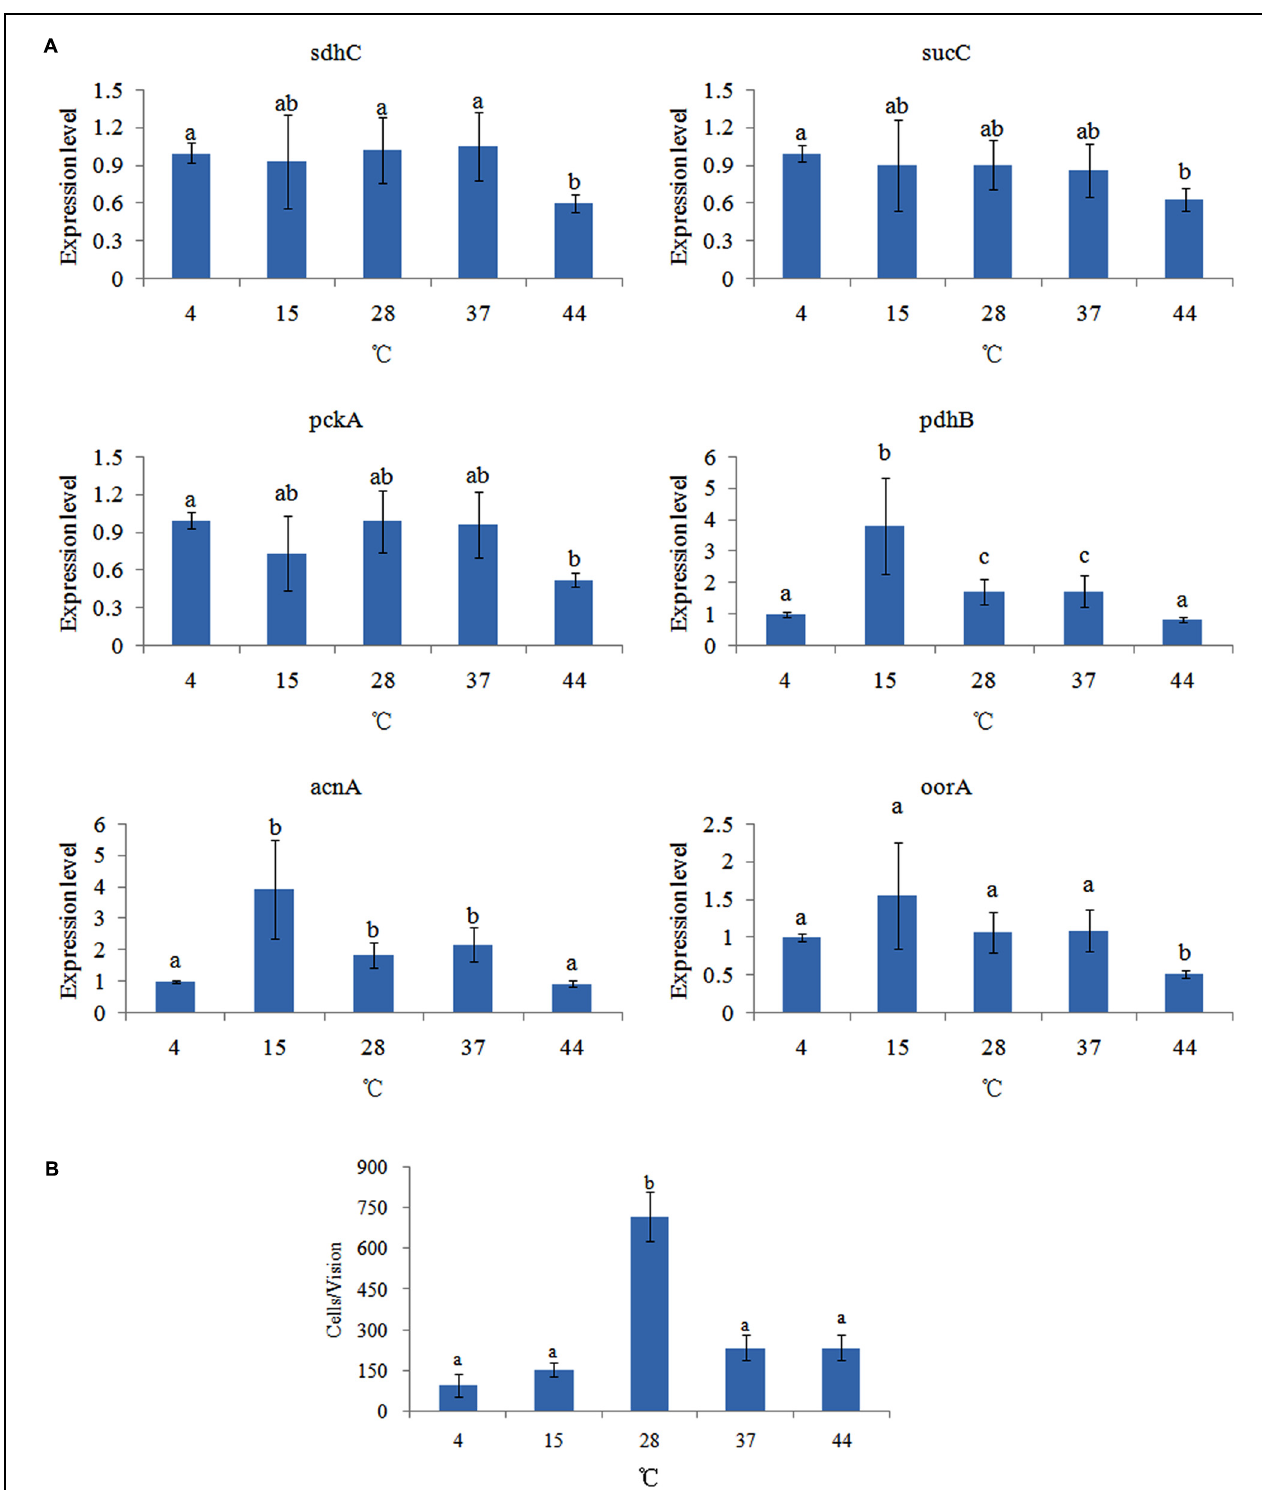
FIGURE 3 | Temperature affected the adhesion of V. alginolyticus . (A) qPCR analysis of the expression of sdhC , sucC , pckA , pdhB , acnA , and oorA after treated with different temperatures. The data are presented as the means ± SD, n = 6. The means of the treatments not sharing a common letter are significantly different at P < 0.05. (B) The adhesion capacity to mucus of V. alginolyticus cultured under different temperatures. The data are presented as the means ± SD, n = 3. The means of the treatments not sharing a common letter are significantly different at P < 0.05, as assessed using one-way ANOVA followed by Dunnett’s